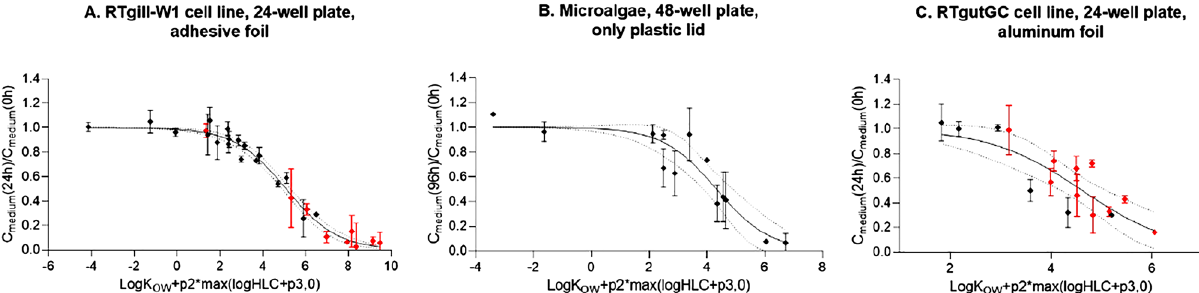
Figure 3. Model calibration (95%CI—confidence intervals) for different covering methods: ( A ) adhesive foil, ( B ) only plastic lid, ( C ) aluminium lid. Chemical concentrations (fraction of concentration in exposure medium at 24 h over 0 h) are plotted dependent on log K OW , logHLC and fitted model parameters p2 and p3 from Eq. (3) (for parameter values see Table S5). Red symbols represent volatile chemicals (logHLC > − 5.61 13